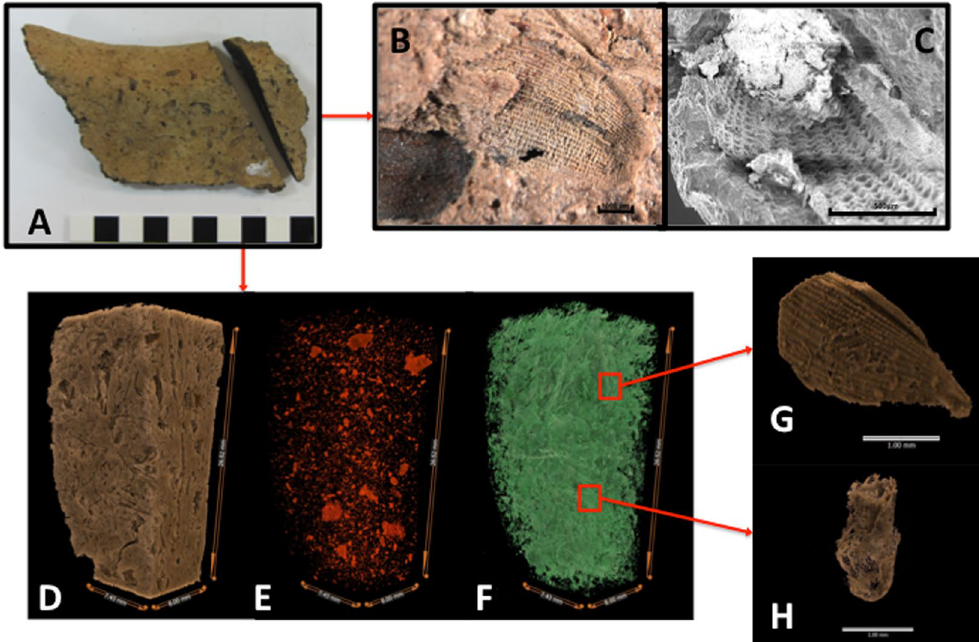
Figure 2. ( A ) – Photograph of Sherd 1 (An Son) showing offcut used for tomographic imaging. ( B ) – Optical microscope image of rice impression on surface of Sherd 1. ( C ) – SEM image of rice impression on exposed cut surface of Sherd 1. ( D ) – Tomograph showing high-density, highly attenuated, clay fraction within offcut of Sherd 1. ( E ) – Tomograph showing mineral fraction within offcut of Sherd 1. ( F ) – Tomograph of low-density organic inclusions within offcut of Sherd 1. ( G ) – Tomograph of targeted rice husk fragment in offcut of Sherd 1, showing distinctive checkboard patterning of epidermis. ( H ) – Tomograph of rice spikelet base in offcut of Sherd 1, identified by positional relationship with husk fragments and recessed, irregular abscission scar. See Animations S1–S5 for detail of Fig.